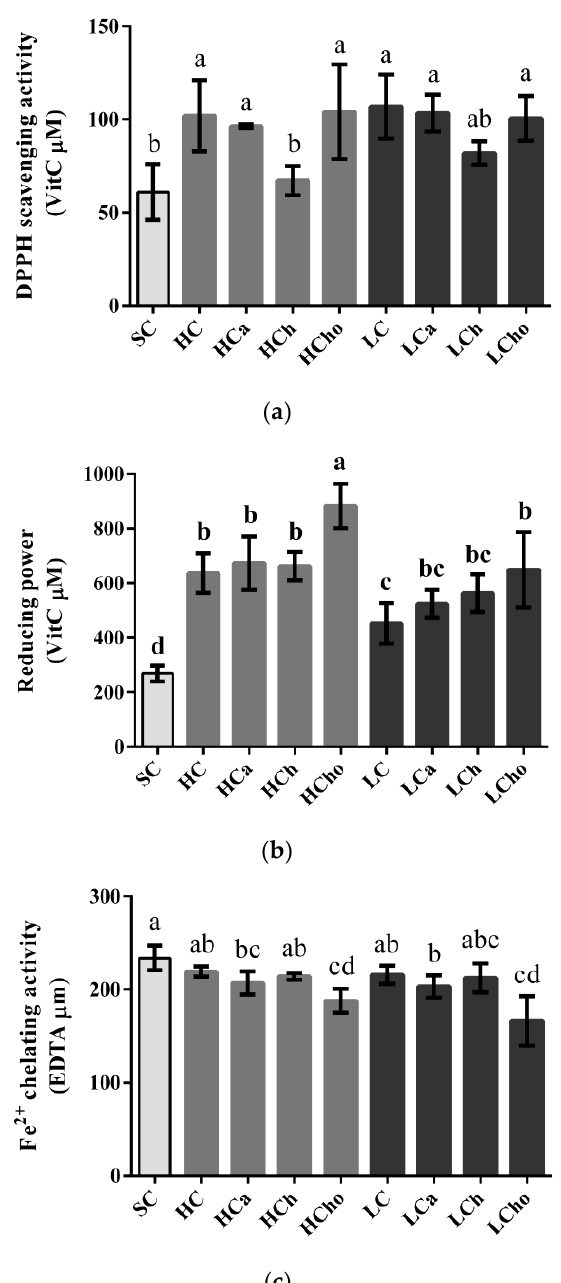
Figure 5. Effect of calcium carbonate, chitosan, and chitooligosaccharide on 1,1-diphenyl-2- picrylhydrazyl hydrate (DPPH) radical-scavenging activity ( a ), reducing power ( b ), and Fe 2+ chelating activity ( c ) in brown sugar cookies. a – d Indicate significant difference between different groups (n = 3; p < 0.05). SC: Sucrose cookie; HC: High acrylamide level of brown sugar in cookie; HCa: HC +